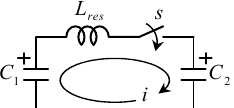
18 of 35 Figure 21. Store energy ratio among the final and the initial condition. Before analyzing the resonant switched-capacitor circuit, we would like to emphasize that it is not difficult to transfer charge among capacitors with efficiencies over 95% in pure switched-capacitor circuits.